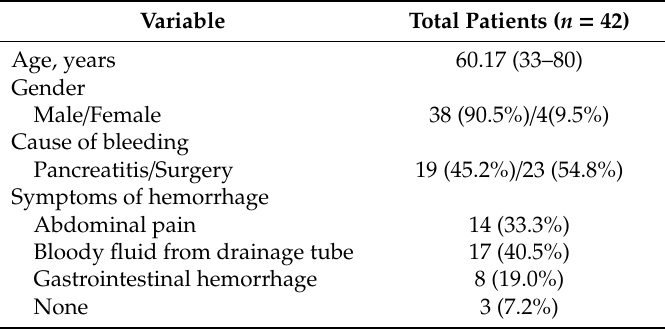
Table 1. Study population